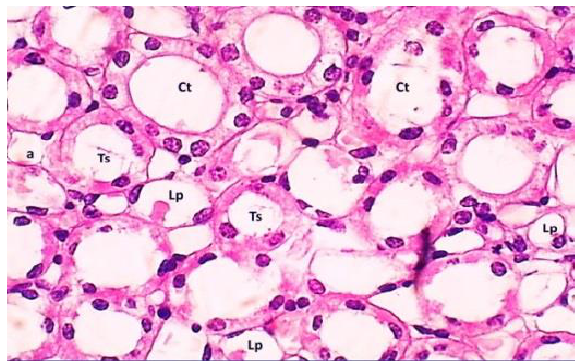
Figure, 8: Histological section of renal cortex shows glomerulus (G) proximal tubule (Pt) and brush border (arrow), distal tubule (Dt) collecting duct (Ct). H&E stain. 400x.